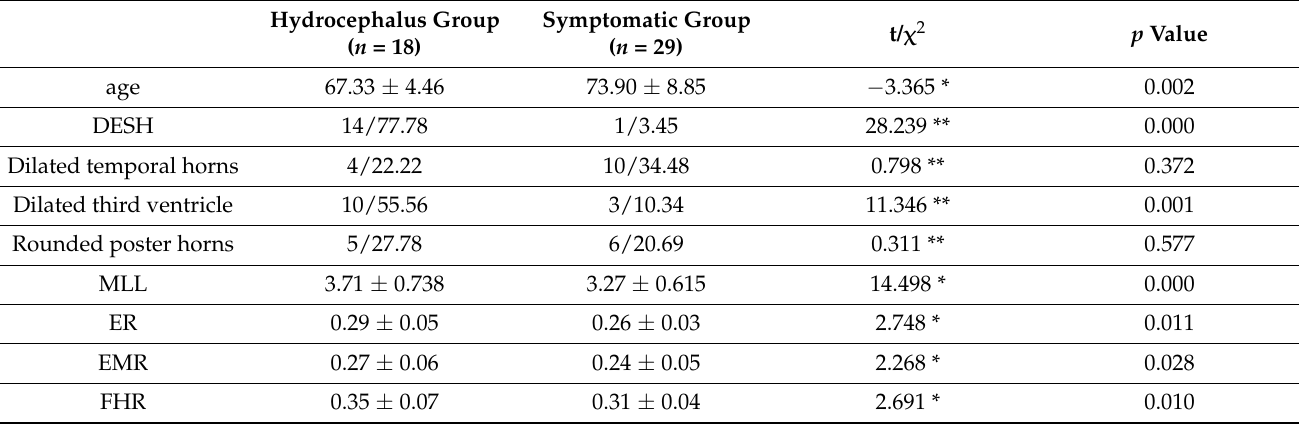
Table 6. The Baseline Statistics Enrolled Patients